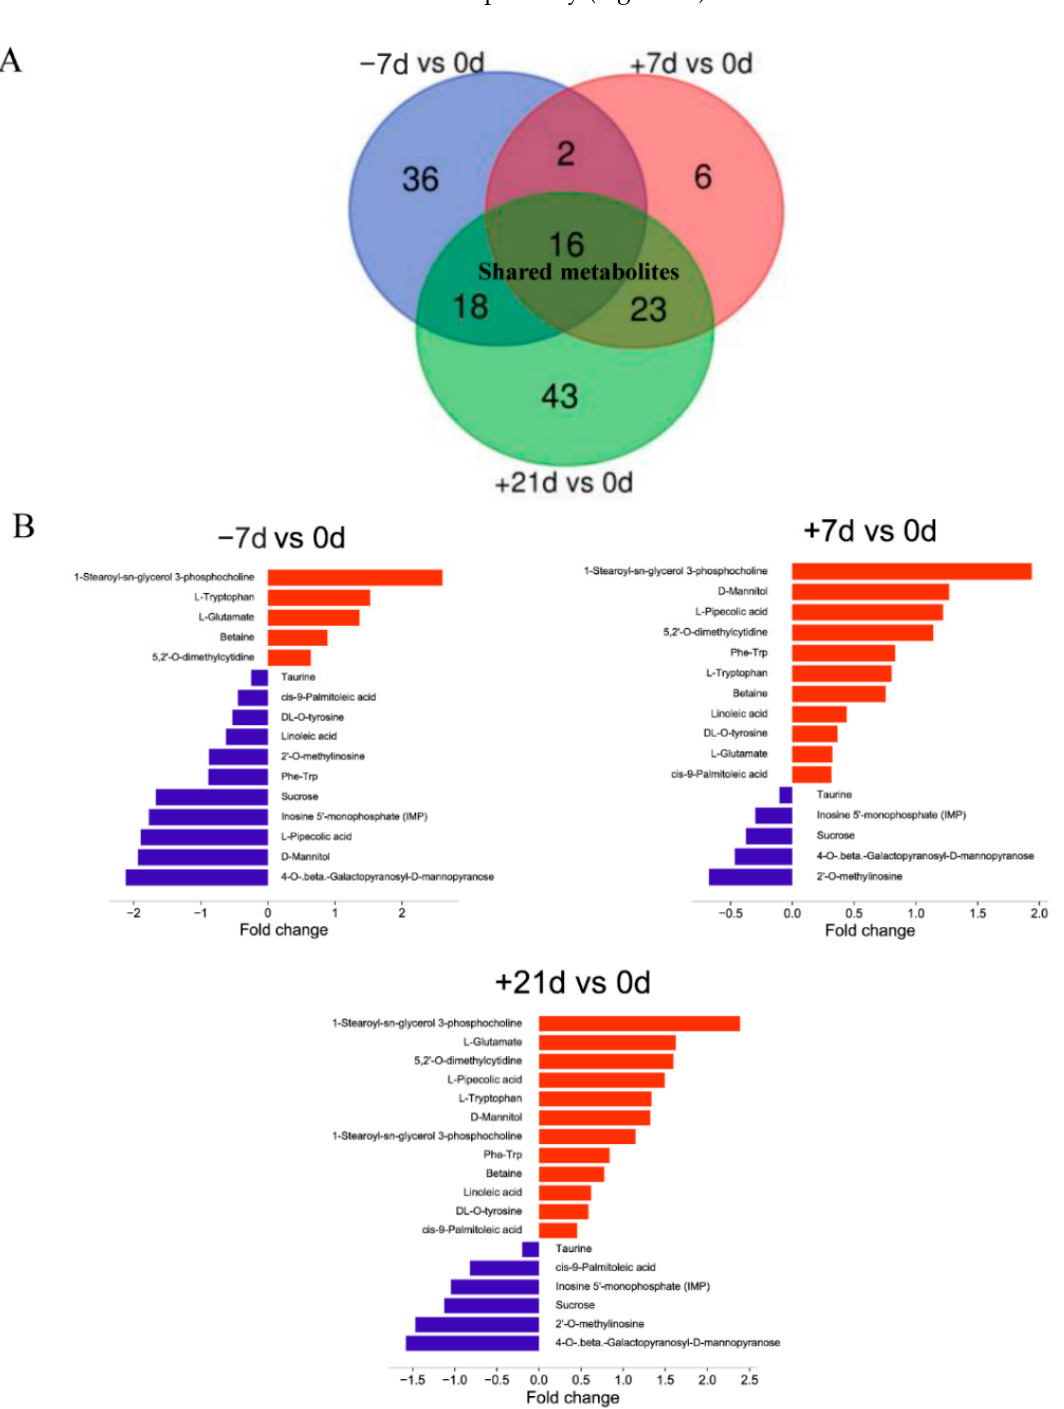
Figure 7. Comparisons of metabolite profiles between − 7 vs. 0 d, +7 vs. 0 d, and +21 vs. 0 d. ( A ) Sixteen metabolites were shared among these three comparisons. ( B ) Bar plot showing the fold-change in shared metabolites in each comparison, where red and blue represent high and low levels, respectively, in the 0 d group.